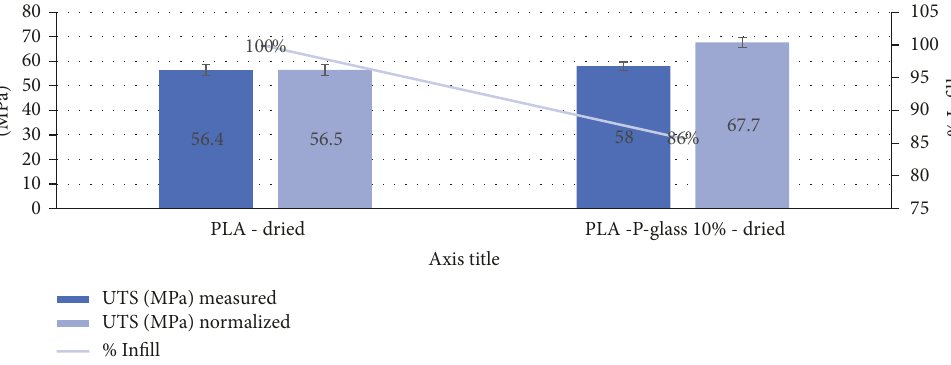
Figure 21: Normalization of UTS values for dried versus undried filament for the PLA